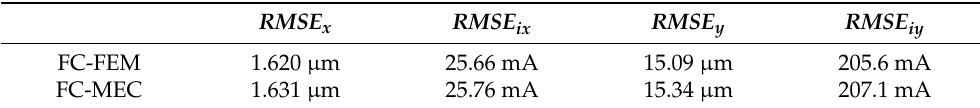
Table 4. RMSE values for a step change of the rotor along the y -axis RMSE